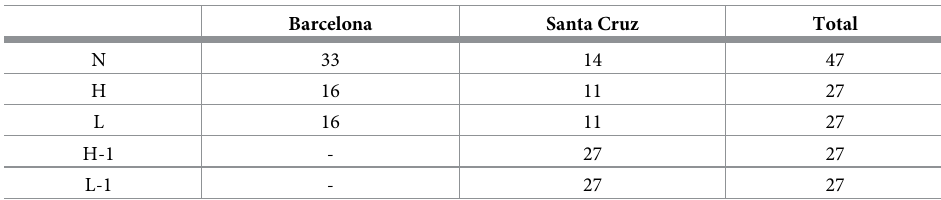
Table 3. Arbiters by treatment and location.